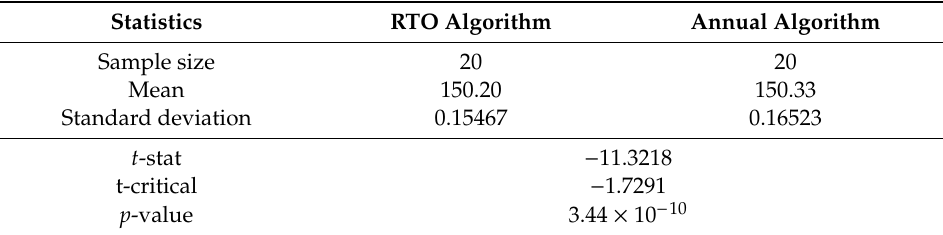
Table 5. Data results from t -test